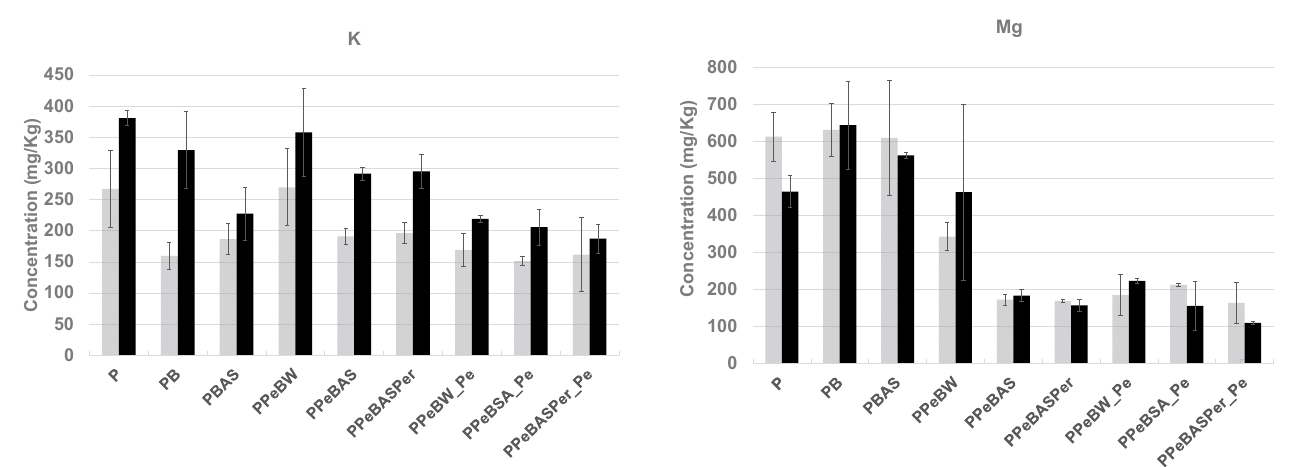
Figure 7. Nutrient contents from the substrates (collected after 23 weeks): 100% peat (P), 75% peat